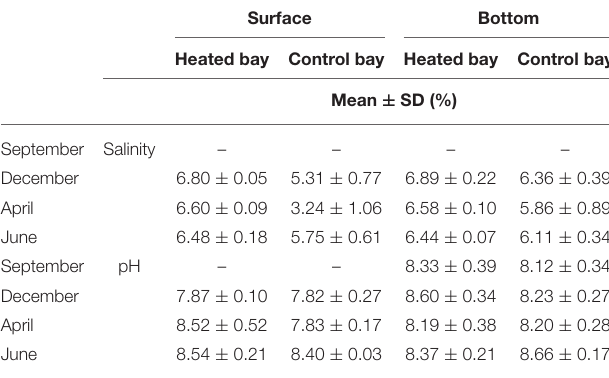
TABLE 1 | Salinity concentration and pH in surface and bottom waters. Surface